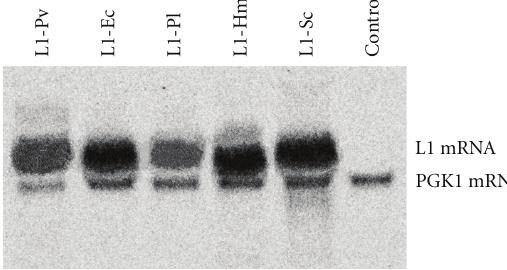
Figure 1: Analysis of HPV-16 L1 mRNA expression in transformed yeast cells by Northern blot. Total yeast RNA was isolated 4h after induction from yeast transformants expressing five di ff erent HPV-16 L1 ORFs and control yeast cells transformed with the empty pFX7 vector. Fifteen micrograms of total RNA was loaded per lane and hybridized with L1-Pv, L1-Ec, L1-Pl, L1-Hm, and PGK1-control cDNA probes labeled with [ α -33P]-dATP by random priming. The data from one representative experiment are shown. The 4 independent experiments with other randomly picked transformants in every group were performed with similar results.